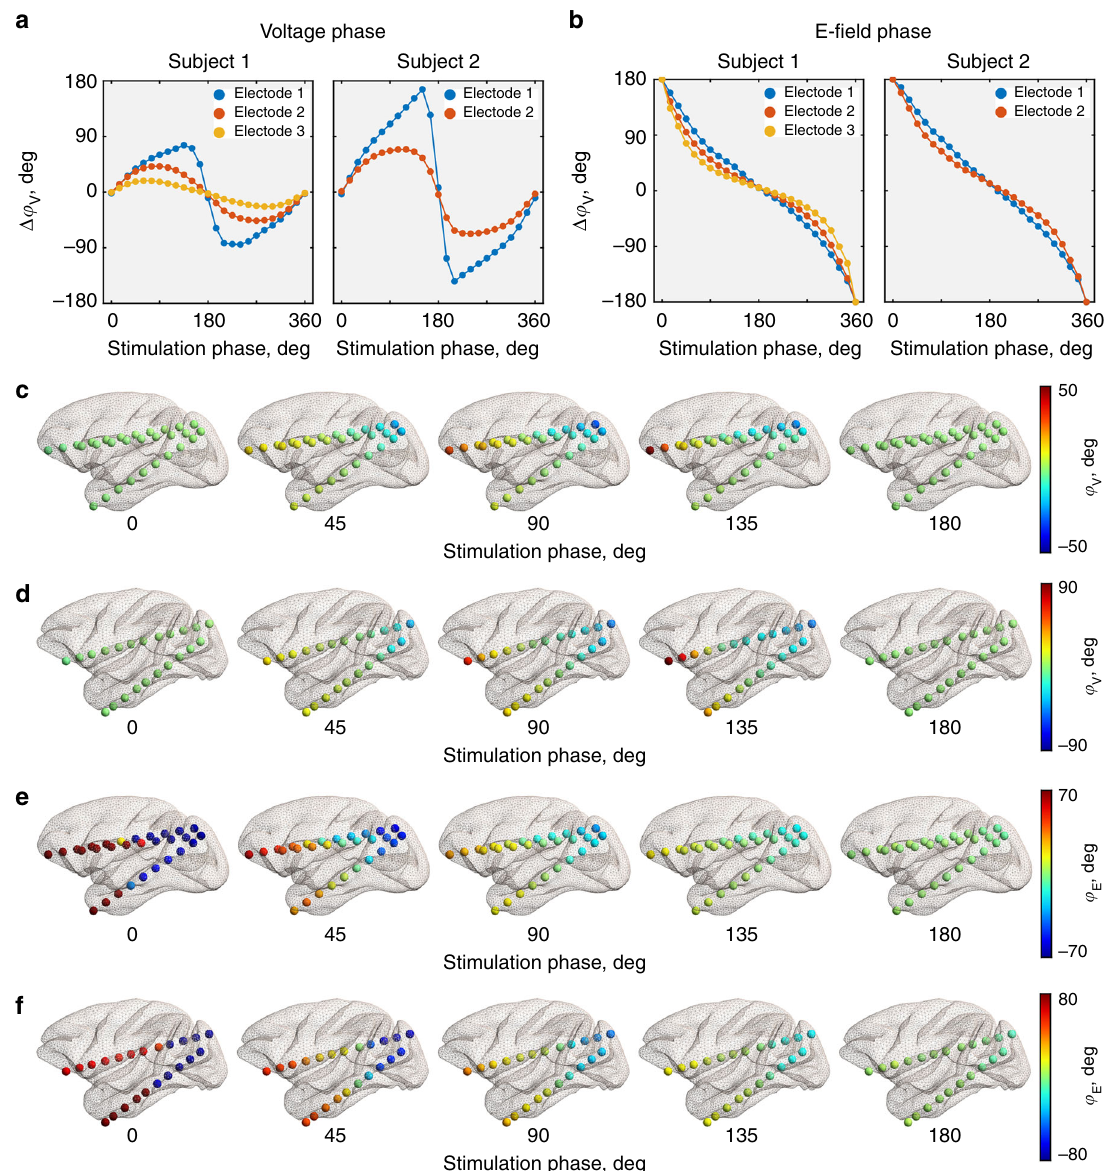
Fig. 4 Voltage and electric fi eld phases in the brain during TES for a given stimulation condition. a The difference between the voltage phases recorded from the most anterior and most posterior contact ( Δ φ V ) per each electrode. The left fi gure corresponds to subject 1, and the right fi gure to subject 2. b Same as panel a, but for the electric fi eld phase differences ( Δ φ E ). c 3D visualizations of the voltage phases ( φ V ) in the brain for the primary stimulation conditions at all recording contacts for subject 1 and subject 2 ( d ). e , f Same as panels c and d , but for the electric fi eld phase ( φ E ). See also